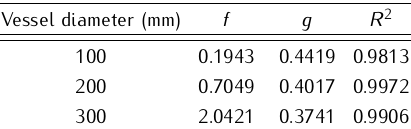
Table 8. Values of f and g parameters in Equation (2) with their relevant R 2